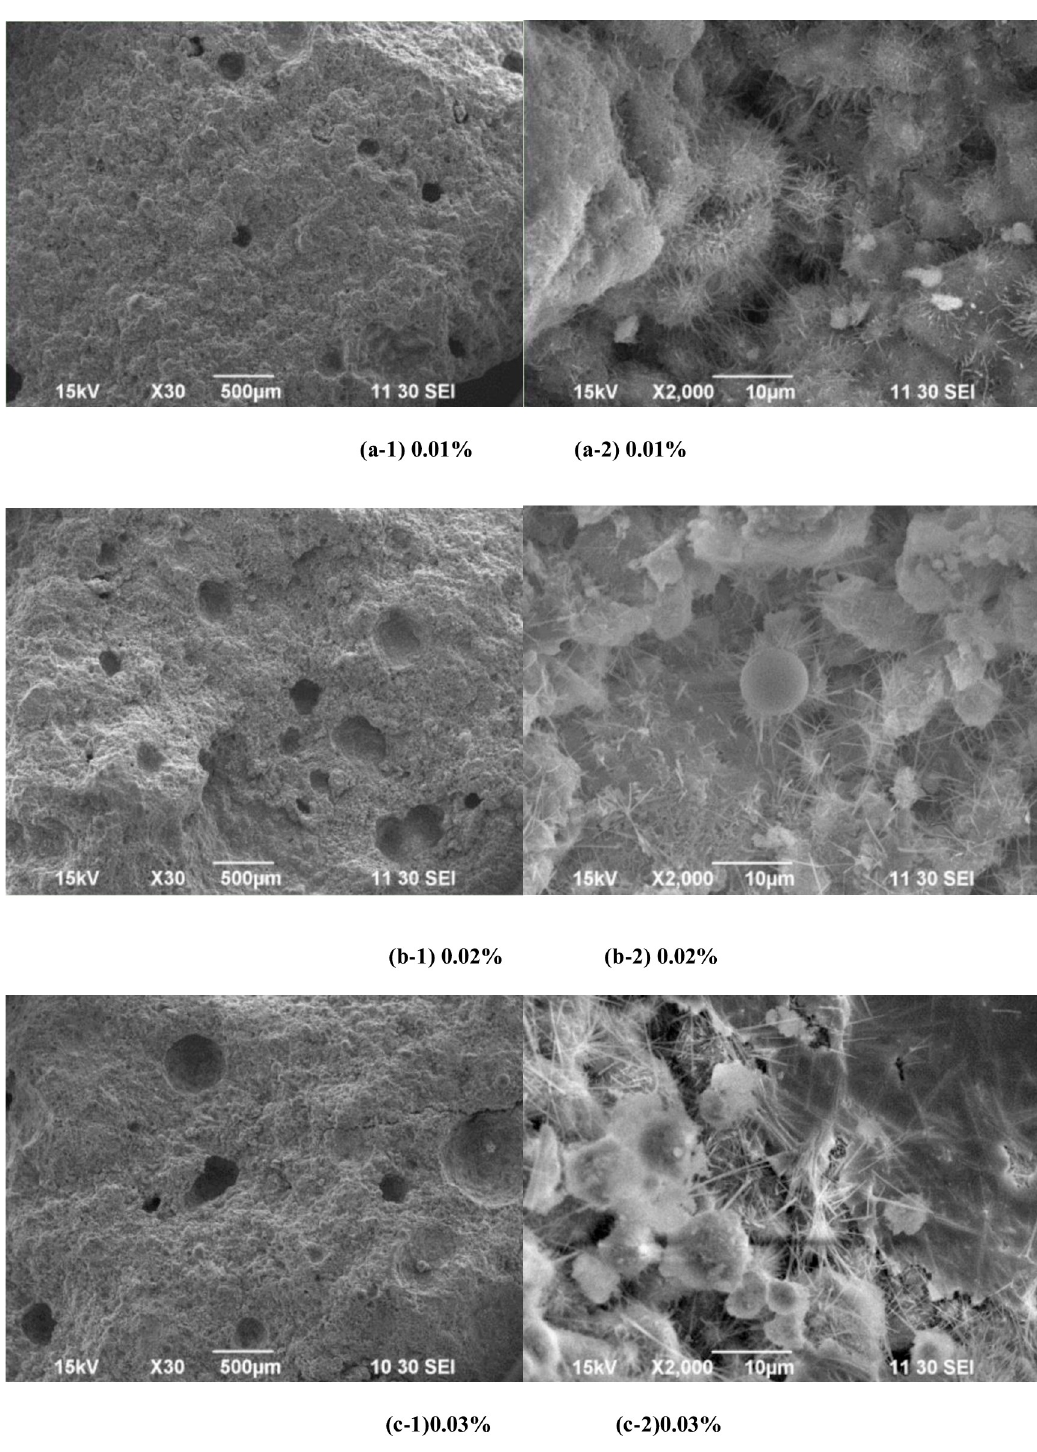
Fig 2. Hardening structures with different aluminum powder amounts. (a-1) 0.01% (a-2) 0.01% (b-1) 0.02% (b-2) 0.02% (c-1) 0.03% (c-2)0.03%.